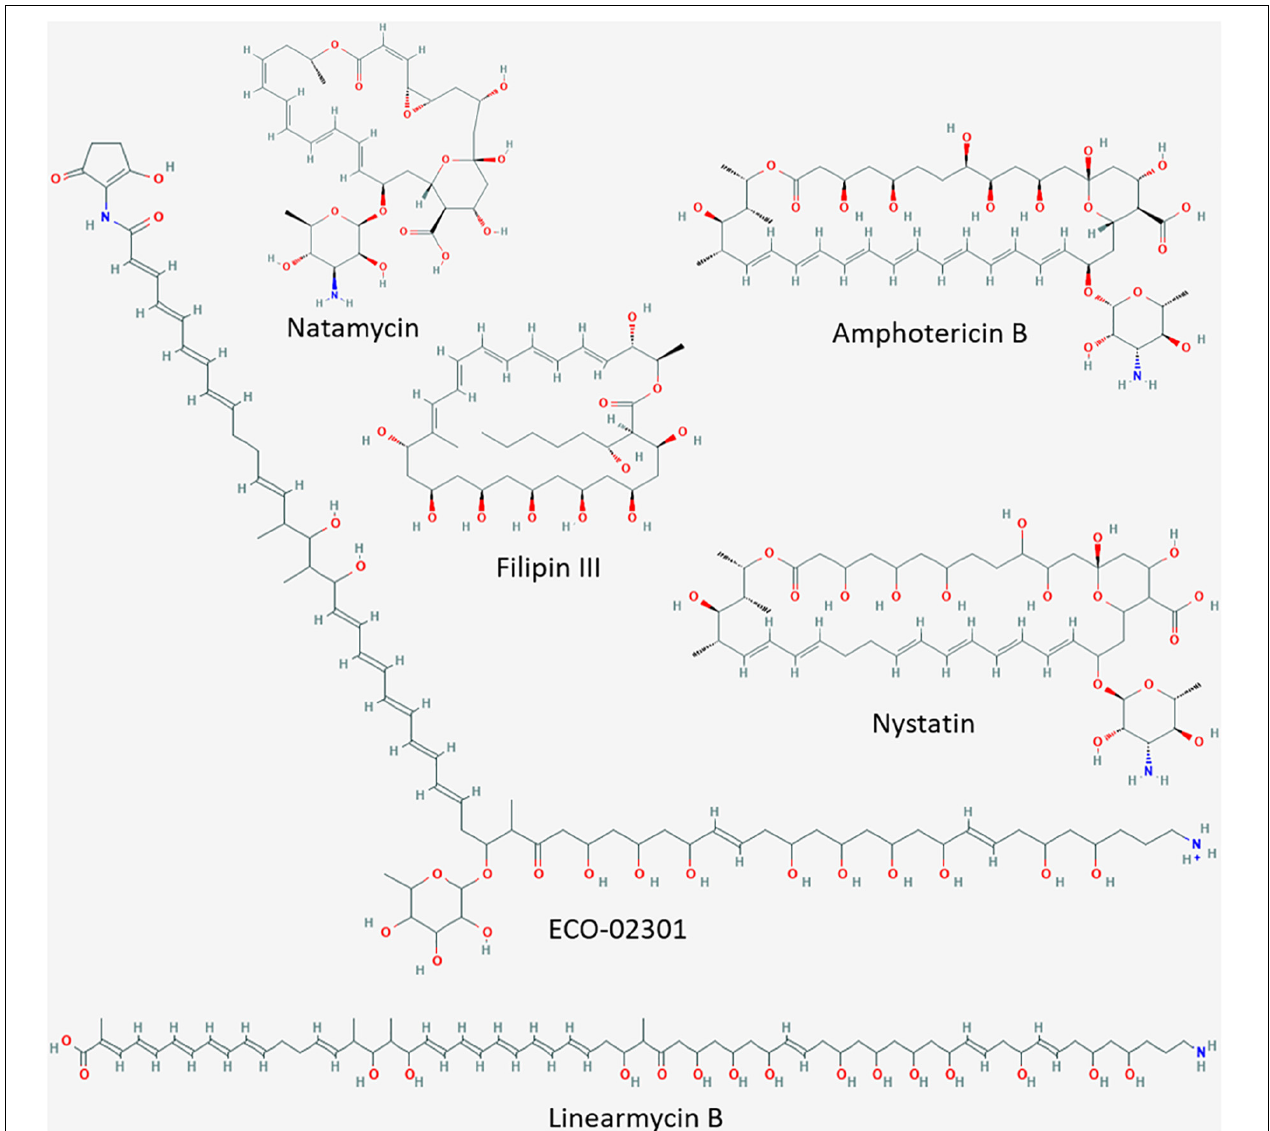
FIGURE 1 | Cyclic and linear polyenes. Molecular structure images downloaded from National Center for Biotechnology Information, PubChem Database (accessed on Apr. 20, 2020) (Kim et al., 2015). Amphotericin B, CID = 5280965 (https://pubchem.ncbi.nlm.nih.gov/compound/5280965#section~=~2D-Structure); nystatin, CID = 6433272 (https://pubchem.ncbi.nlm.nih.gov/compound/6433272#section~=~2D-Structure); ECO-02301, CID = 90658124 (https://pubchem.ncbi.nlm. nih.gov/compound/90658124#section = 2D-Structure); filipin III, CID = 6433194 (https://pubchem.ncbi.nlm.nih.gov/compound/6433194#section = 2D-Structure); natamycin, CID = 5284447 (https://pubchem.ncbi.nlm.nih.gov/compound/5284447#section = 2D-Structure); linearmycin B, CID = 10328913 (https://pubchem.ncbi. nlm.nih.gov/compound/10328913#section =